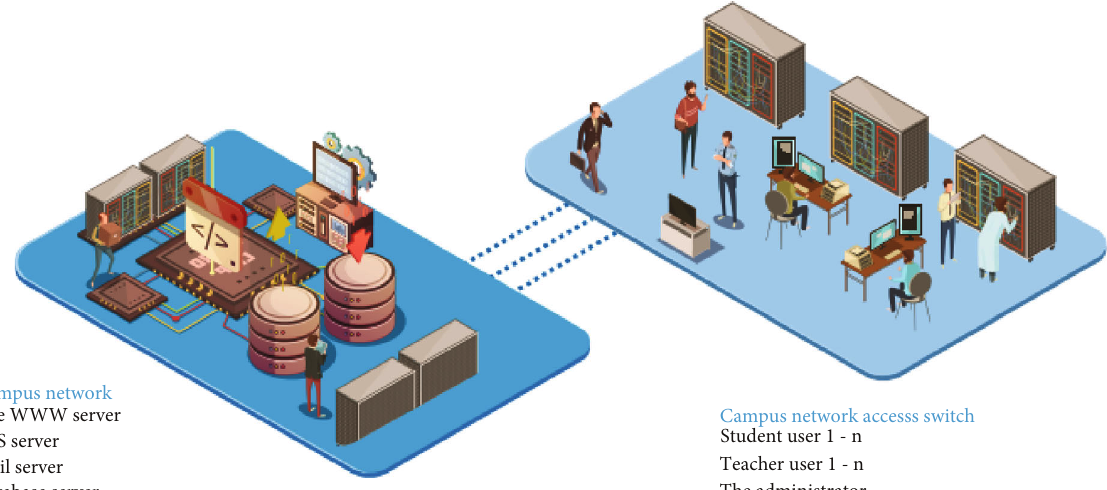
Figure 7: Platform network structure diagram.